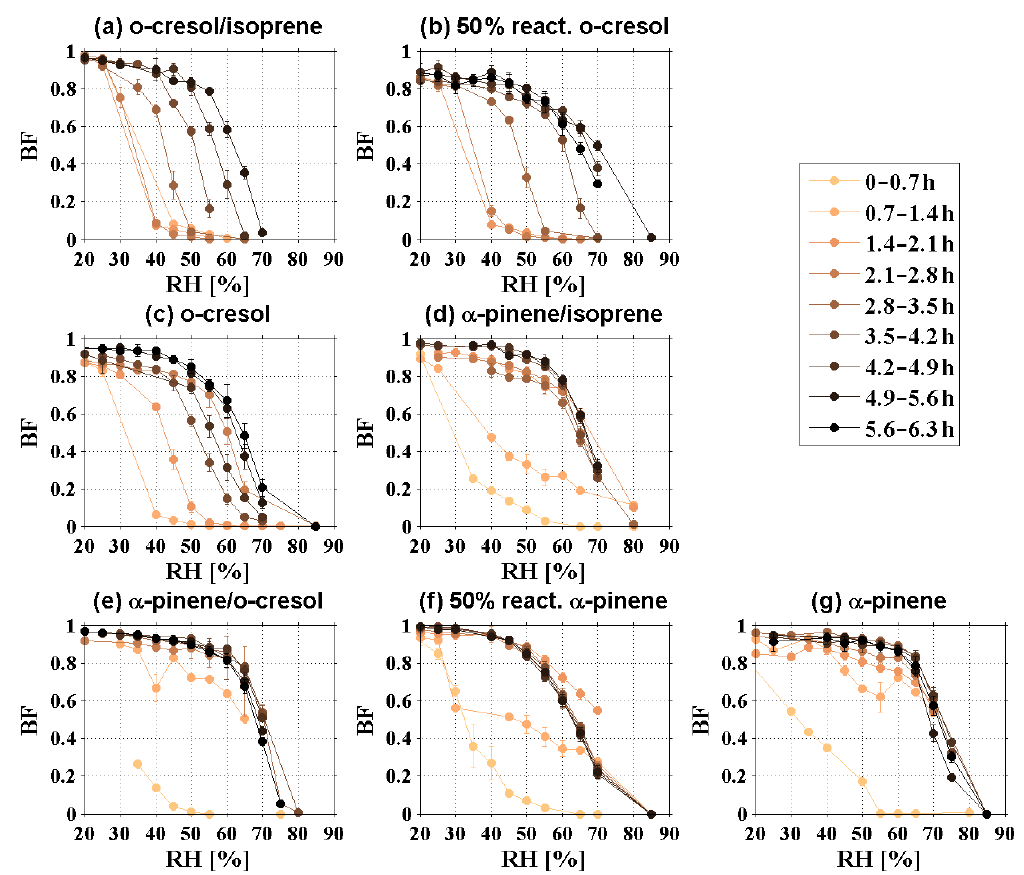
Figure 1. Time series of the bounce fraction (BF) as a function of RH measured by three-arm particle rebound apparatus, with an RH adjustment system of the 100–200nm secondary organic aerosol (SOA) formed from the photochemistry of various iso-reactive single (binary) biogenic (anthropogenic) VOCs (volatile organic compounds) under modest NO x conditions on deliquescent ammonium sulfate seed (as the SOA mass fraction in NR–PM 1 is larger than